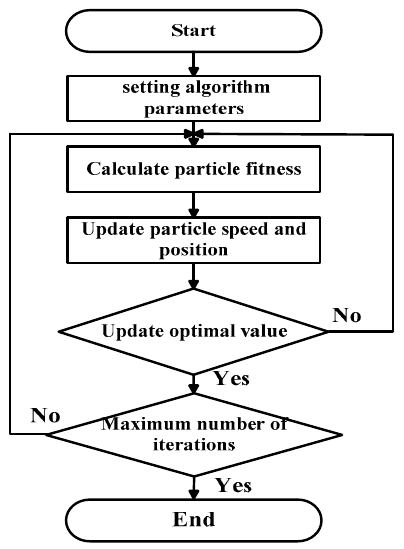
Figure 14. Flow chart of polarization parameter extraction based on particle swarm optimization.